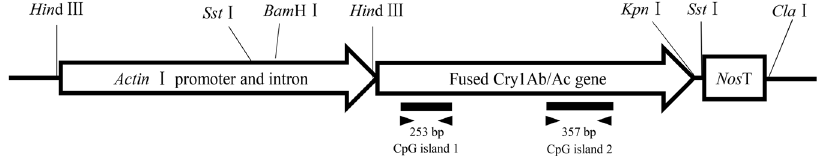
Figure 1. Schematic diagram of the fused Cry1Ab/Ac gene and its